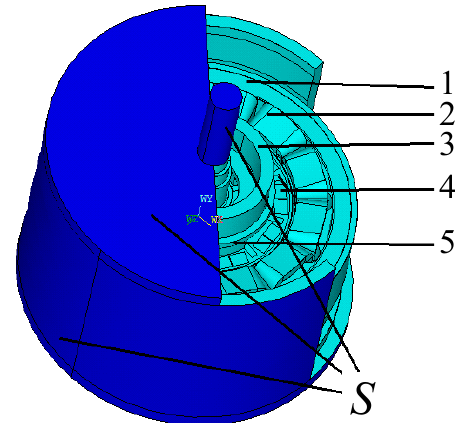
Figure 5. Three-dimensional (3d) steady-state temperature field calculation model. 1-Stator Core, 2-Armature Windings, 3-Axial Field Windings, 4-Permanent Magnets, 5-Ferromagnetic Ring, S -Boundary for Thermal Calculations.